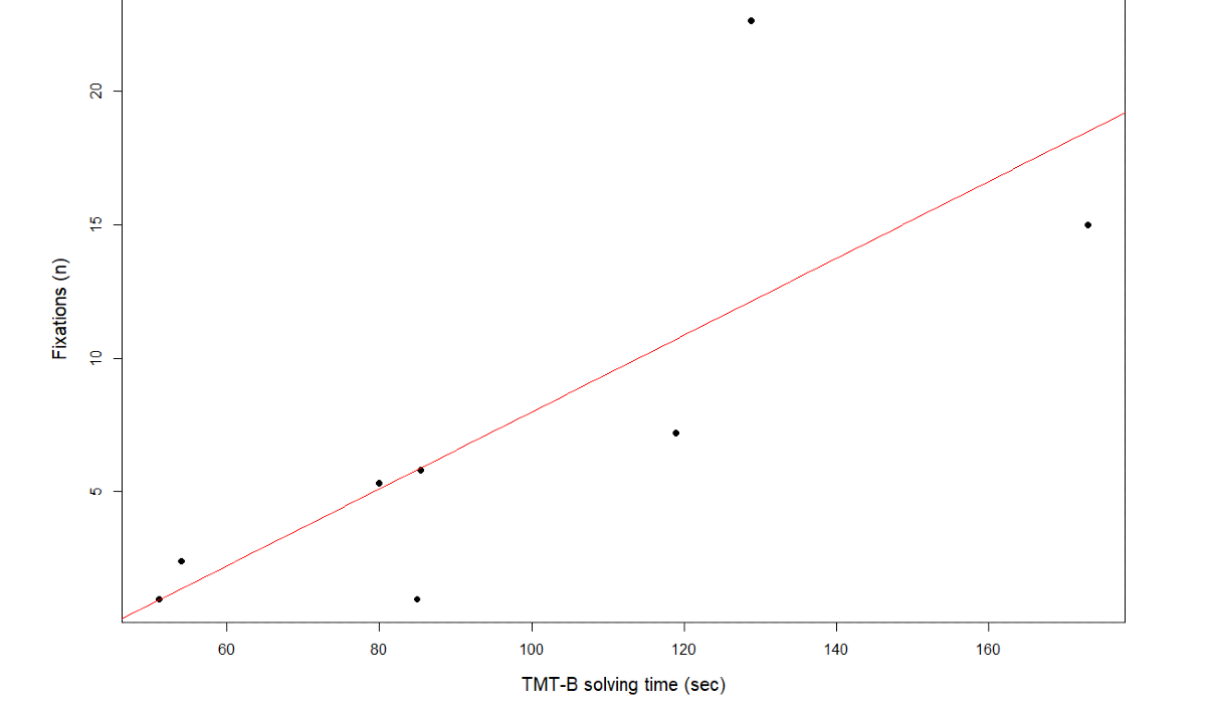
Saccade distance